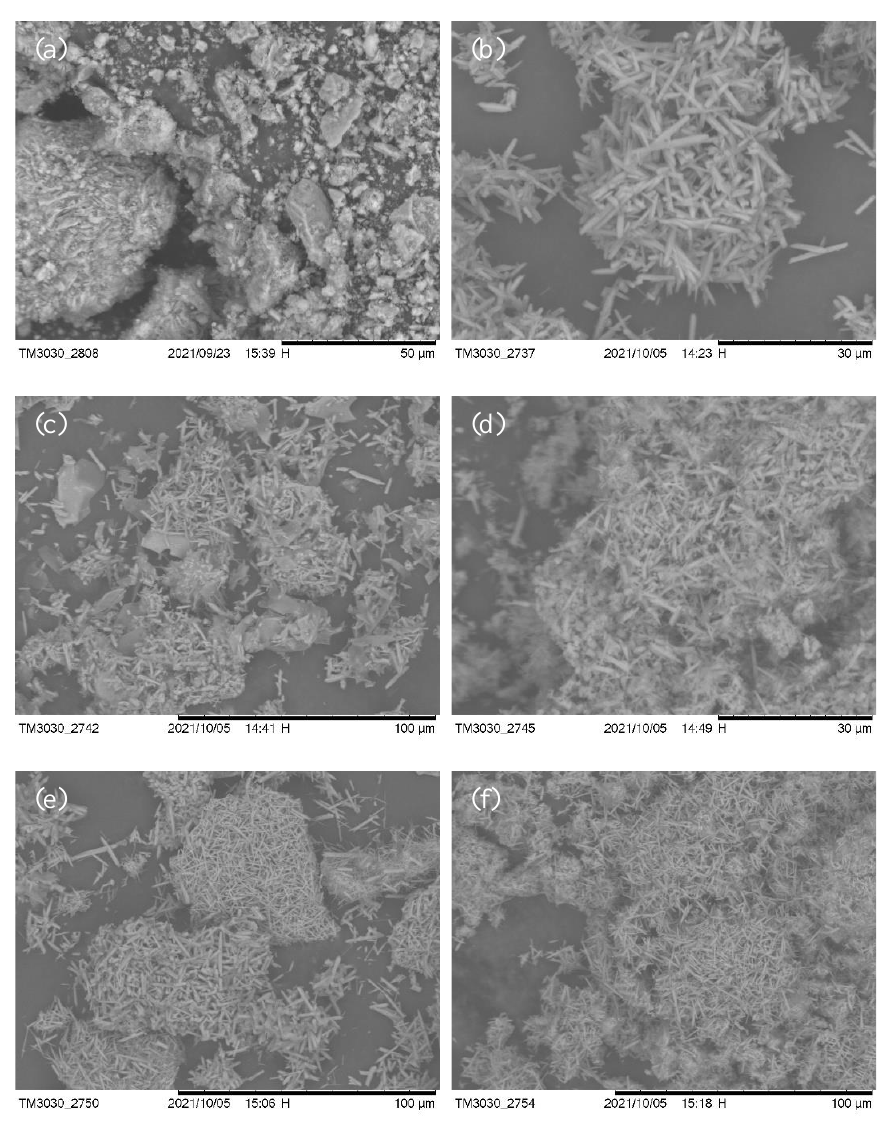
Figure 17. SEM of mullite whisker generation after calcination with different holding times. ( a ) 0 h,